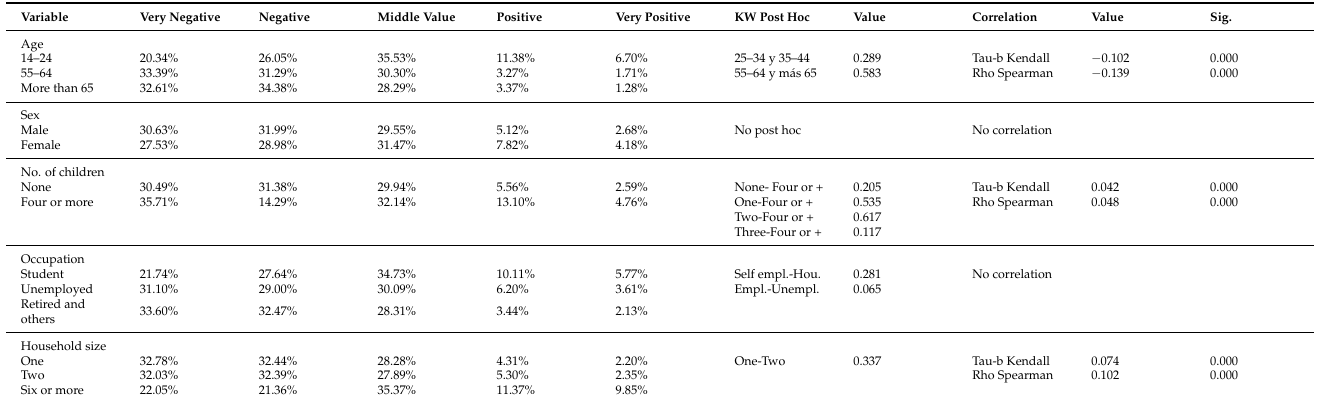
Table 6. User Evaluation of Advertising,